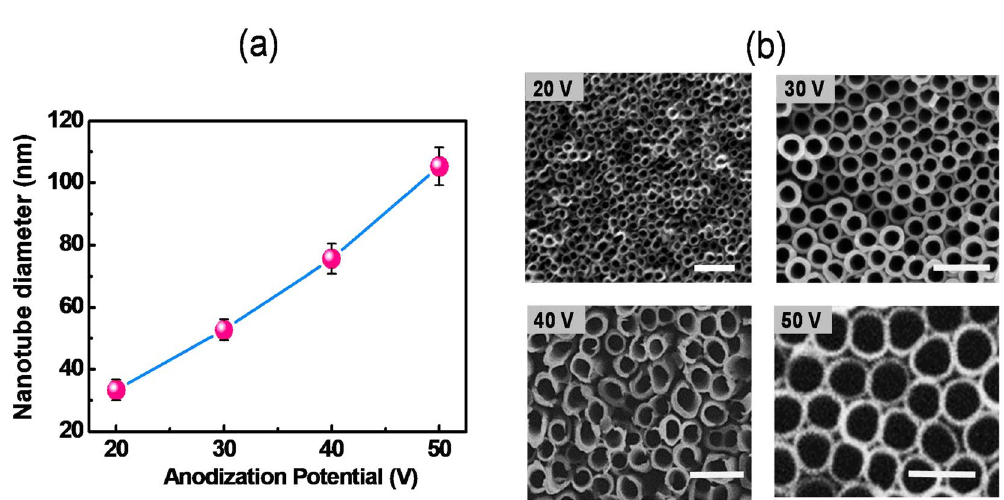
Figure 2. ( a ) Plot of nanotube pore diameter dependence as a function of applied potential during the anodization process. ( b ) Corresponding SEM images of the TiO 2 nanotubes fabricated using voltages of 20–50 V. Scale bar: 200